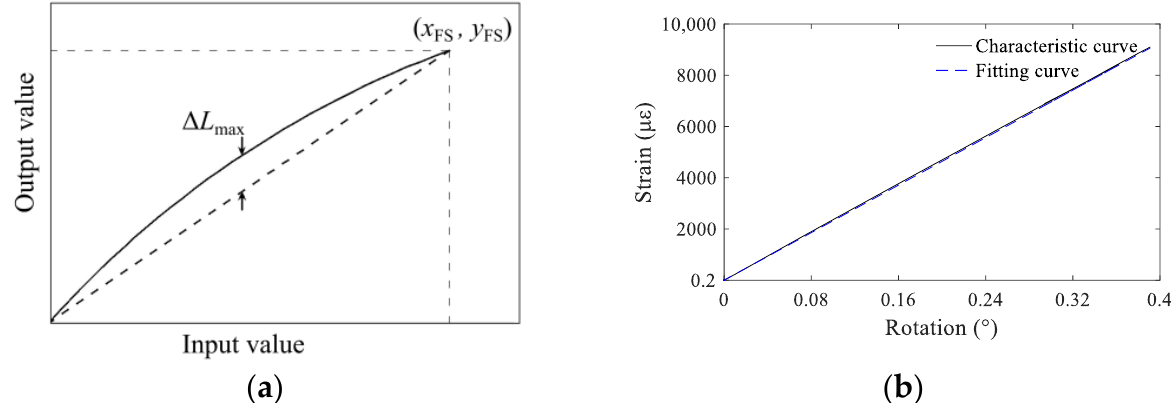
Figure 10. ( a ) Schematic diagram of linearity curve; ( b ) actual linearity of the proposed inclinometer. Similarly, repeatability describes the degree of non-coincidence for the input–output curve when the transducer input changes repeatedly, as shown in Figure 11a. The repeata- bility error can be calculated using Equation (14). If the degree of non-coincidence is large, the output values differ greatly for the same input signal, which also affects the monitoring accuracy. Based on the repeatability characteristic curve of the experimental monitoring data, as shown in Figure 11b, the repeatability error was calculated to be 0.82%.